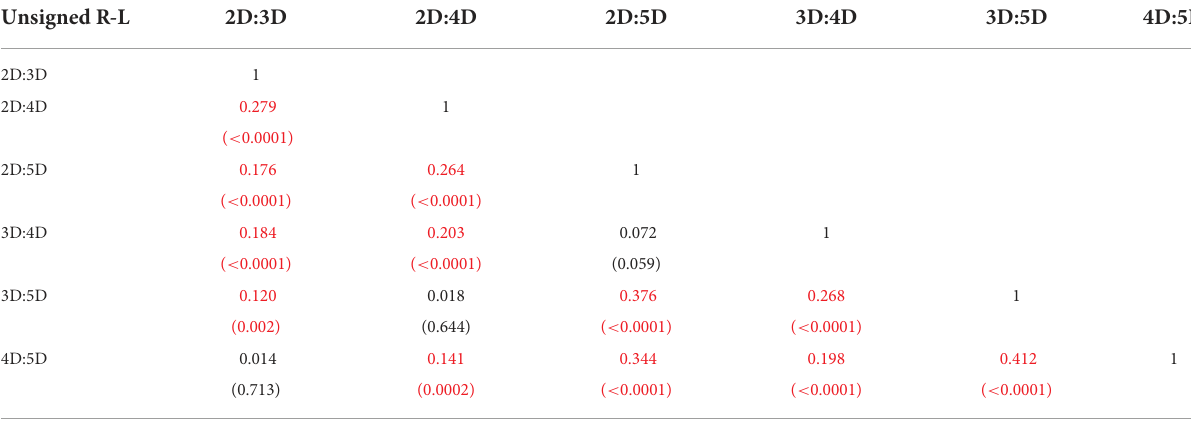
TABLE 3 Correlations between individual unsigned digit ratios asymmetry using the Spearman correlation.